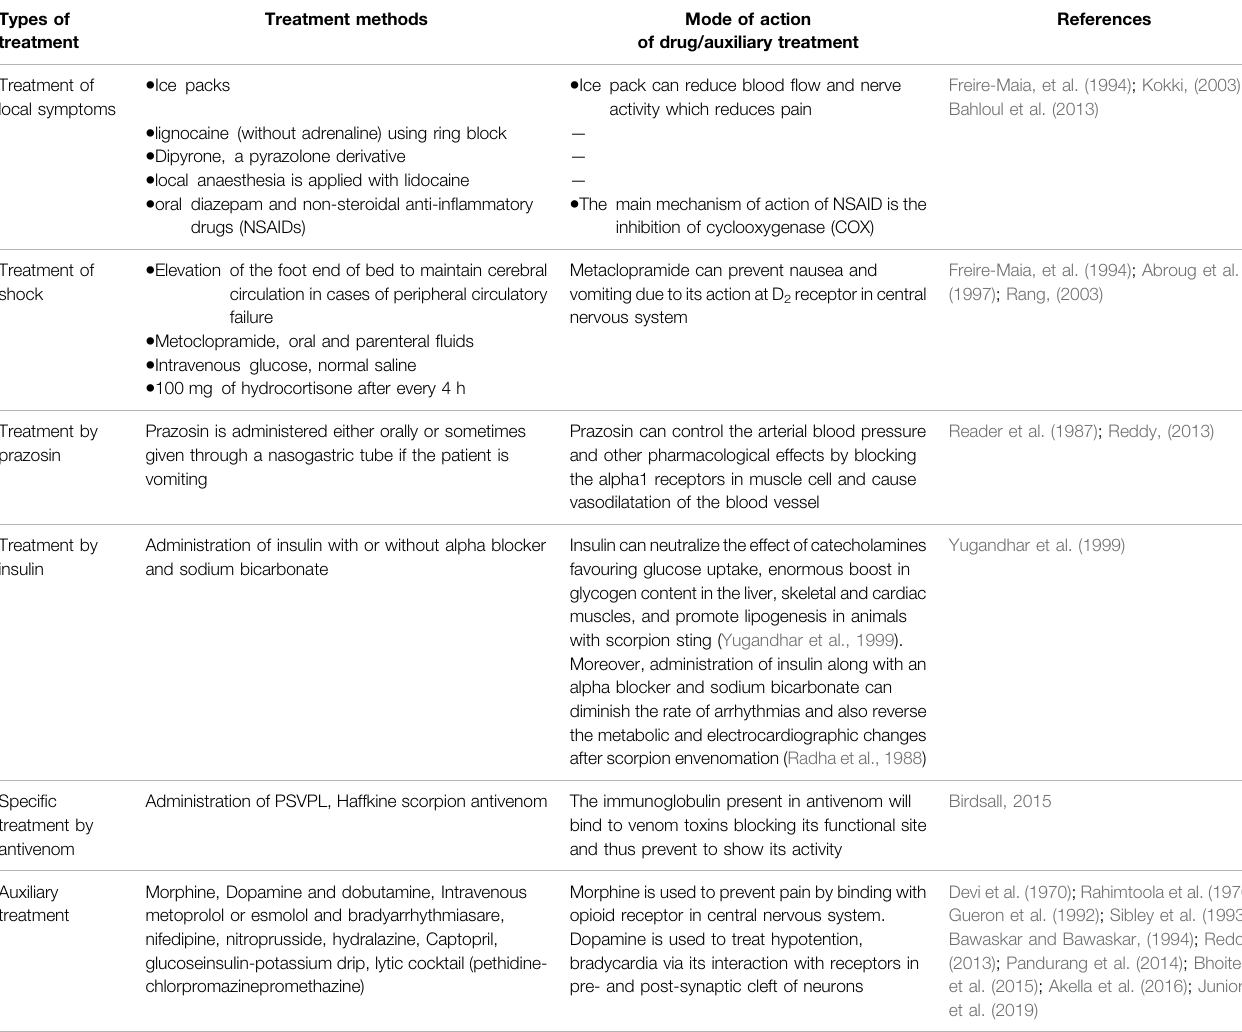
TABLE 3 | Different treatment regimes utilized for scorpion